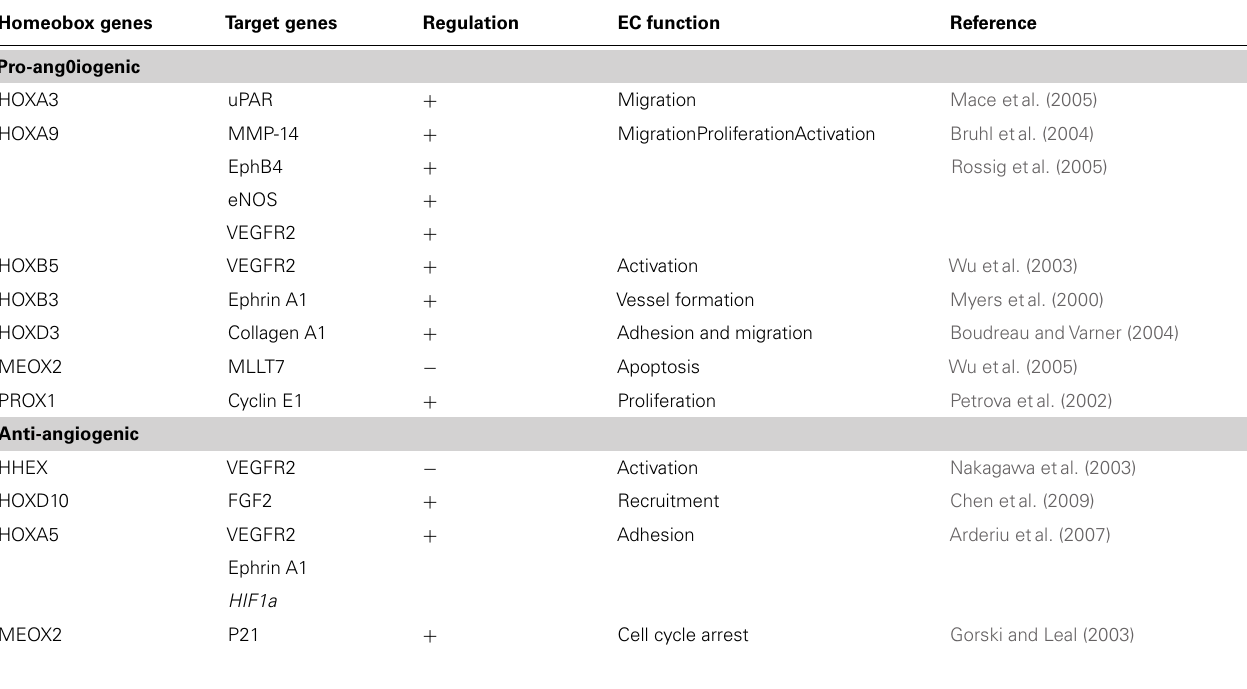
Table 1 | Examples of target genes downstream of homeobox genes required for the regulation of endothelial functions. Homeobox